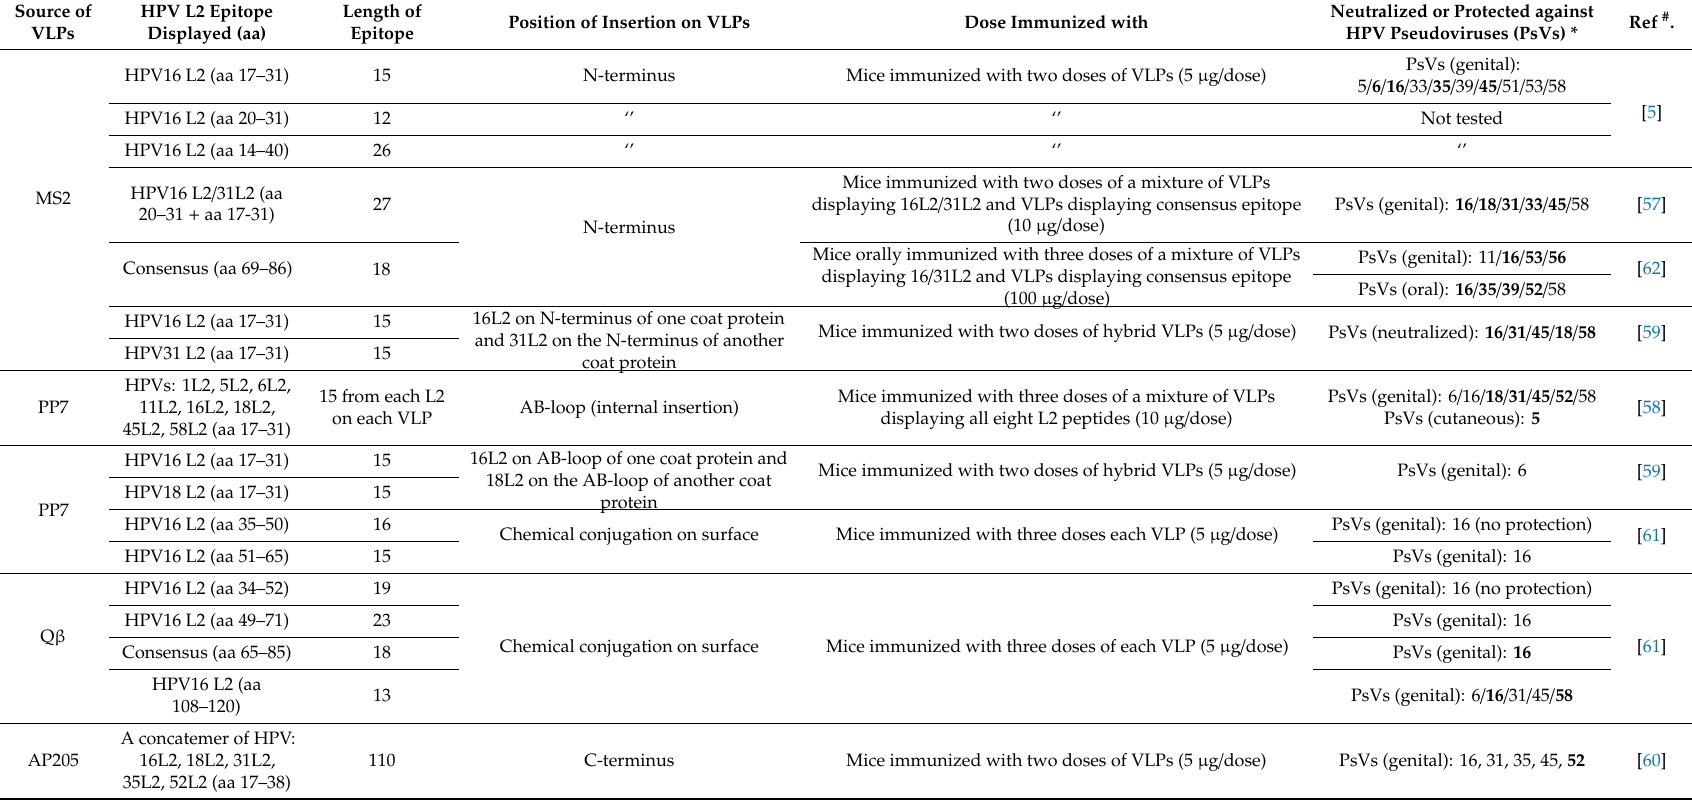
Table 1. Candidate bacteriophage VLP-based L2 HPV